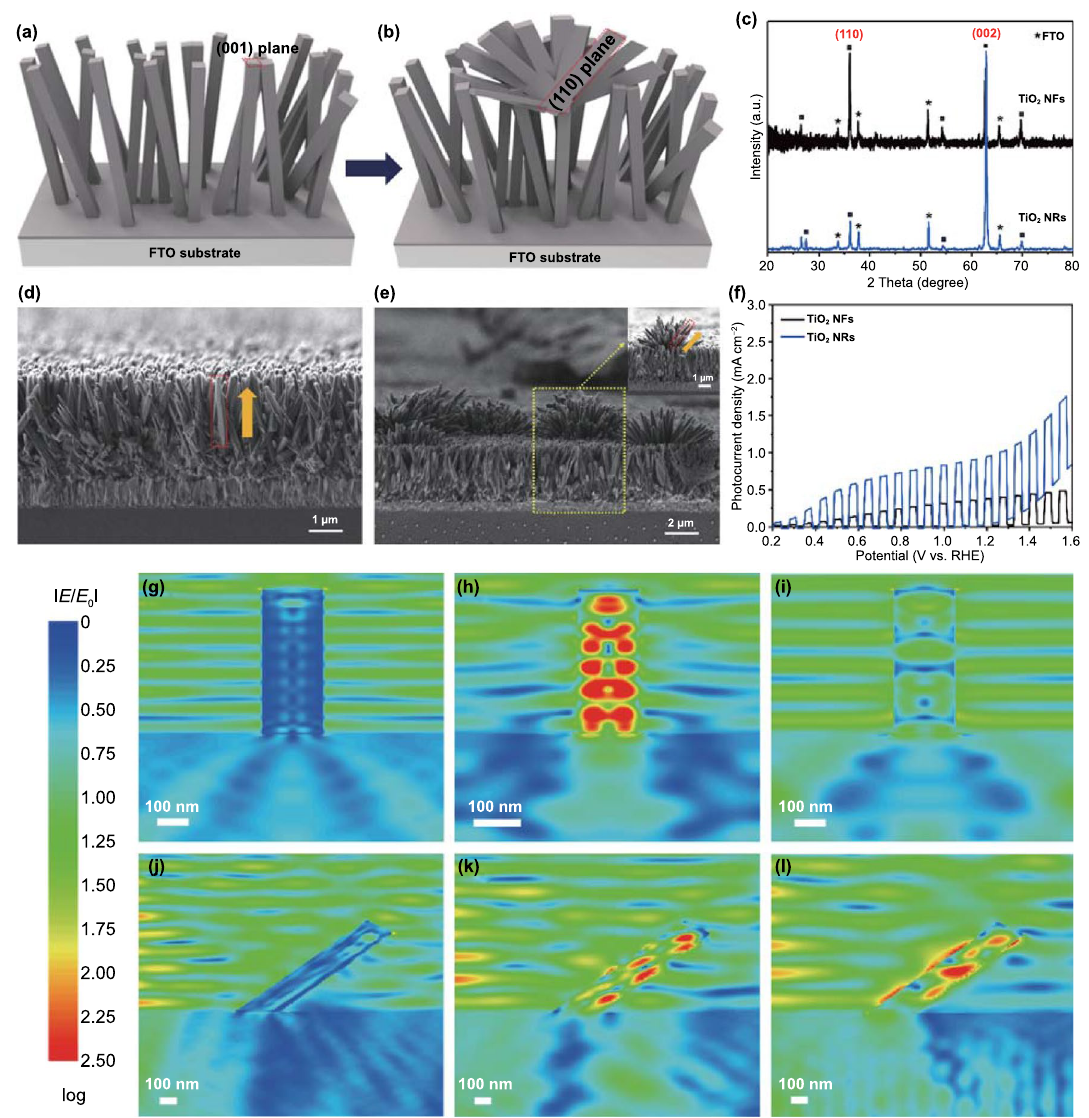
Fig. 1 Schematic illustration of a TiO 2 NRs and b TiO 2 NFs growth via hydrothermal synthesis. c XRD patterns of TiO 2 NRs and TiO 2 NFs. Cross‑sectional SEM images of d TiO 2 NRs and e TiO 2 NFs. f J – V curves of TiO 2 NRs and TiO 2 NFs in 0.5M potassium phosphate (K–P i ) buffer with 1M Na 2 SO 3 . FDTD simulations of near field enhancement of TiO 2 NRs on FTO under g 350 nm, h 450 nm, and i 550 nm photons. FDTD simulations of near field enhancement of TiO 2 NFs on FTO under j 350 nm, k 450 nm, and l 550 nm